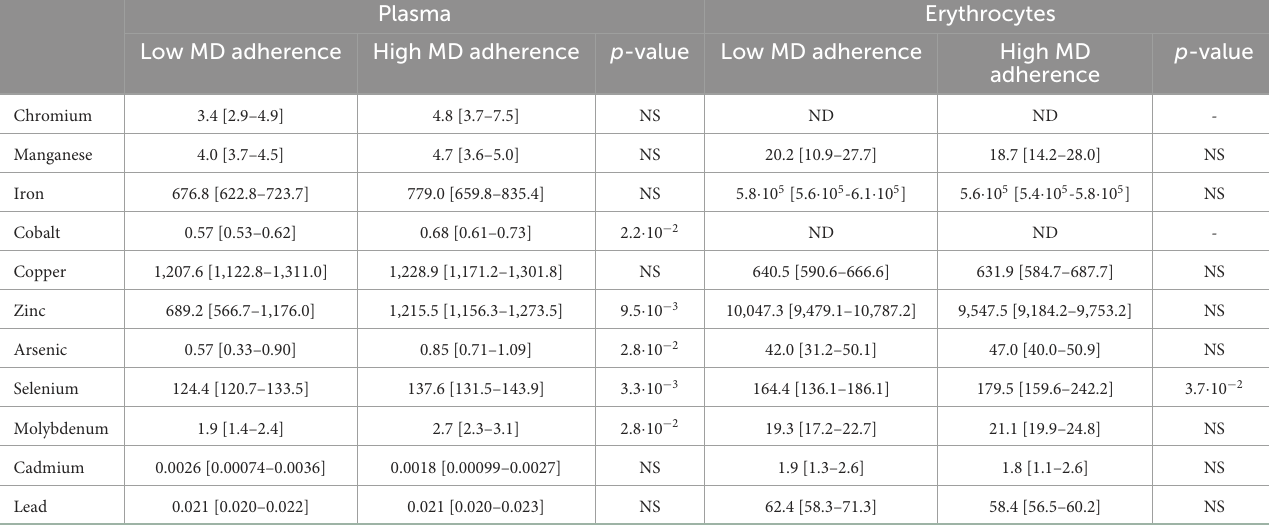
TABLE 2 Plasma and erythroid concentrations of trace elements in the two study groups.